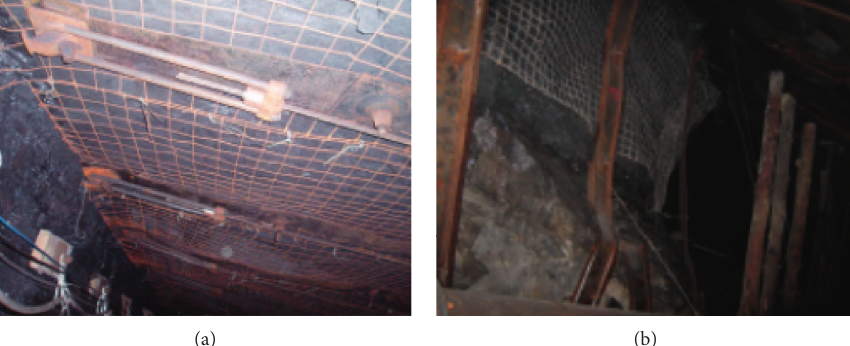
Figure 2: Roadway status. (a) No. 41 coal seam-350 haulage roadway in No. 1 district. (b) No. 41 coal seam-660 haulage roadway in No. 3 district.